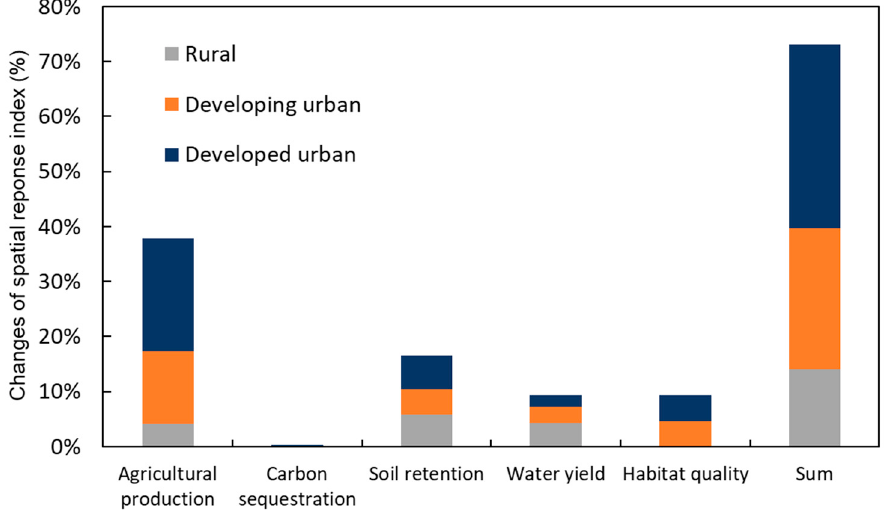
Figure 12. Change in the spatial response index of ecosystem services (ES) with respect to land use and land cover change (LULC) in Foshan under different levels of urbanization from 2000 to 2018. The spatial distribution of spatial response index derived from the total ES with re- spect to LULC is shown in Figure 13. The areas with higher values were more consistent with the distribution of water bodies. Four high-value accumulated areas were mainly distributed in the developing urban area. The spatial response index of the rural areas was lower. The average spatial response index in rural, developing, and developed urban ar- eas was 0.39, 0.71, and 0.45, respectively.